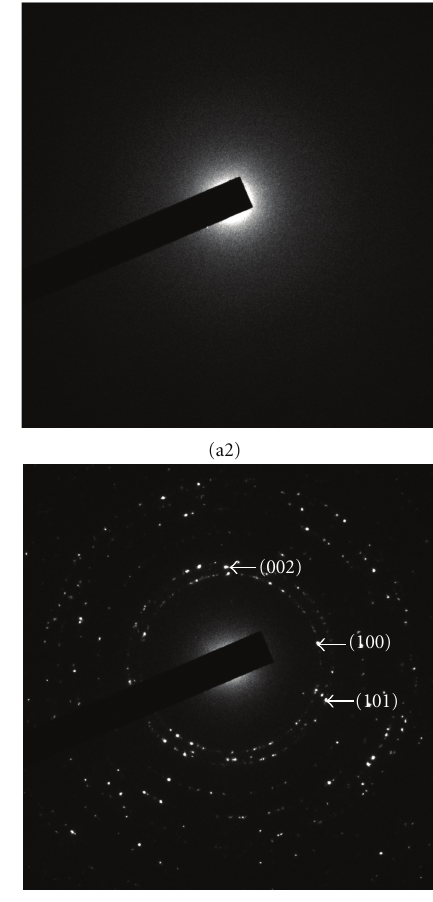
alloy before merging with atmospheric oxygen to form